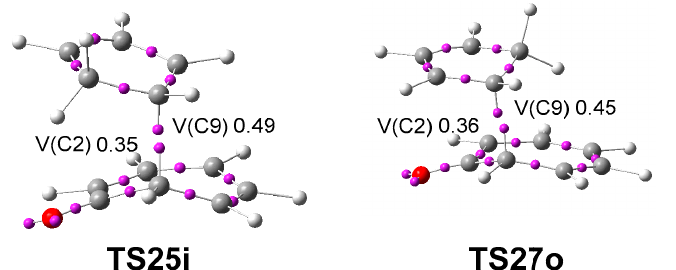
Figure 7. ω B97X-D/6-311G (d,p) ELF basin attractor positions and basin populations, in average number of electrons, e, of the pseudocyclic TS25i and TS27o involved in the nucleophilic attack of the C9 carbon of Cp 3 on the C2 carbon of tropone 1 along the C2–C9 single bond formation.